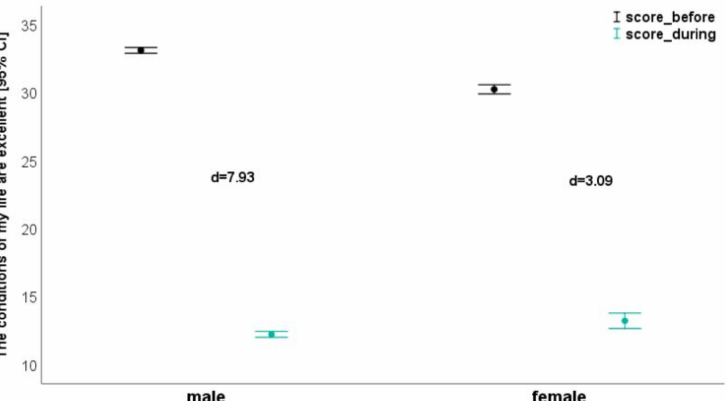
Figure 2. The conditions of my life are excellent—depending on gender before and during confinement.